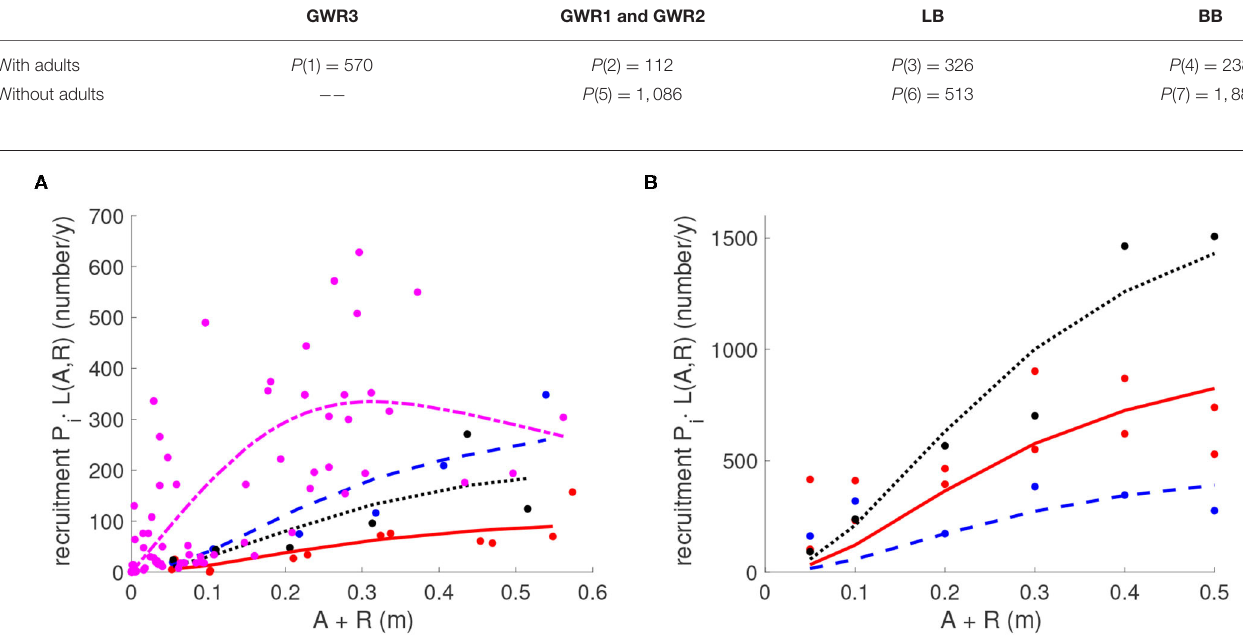
from all sites were combined into a single data set for